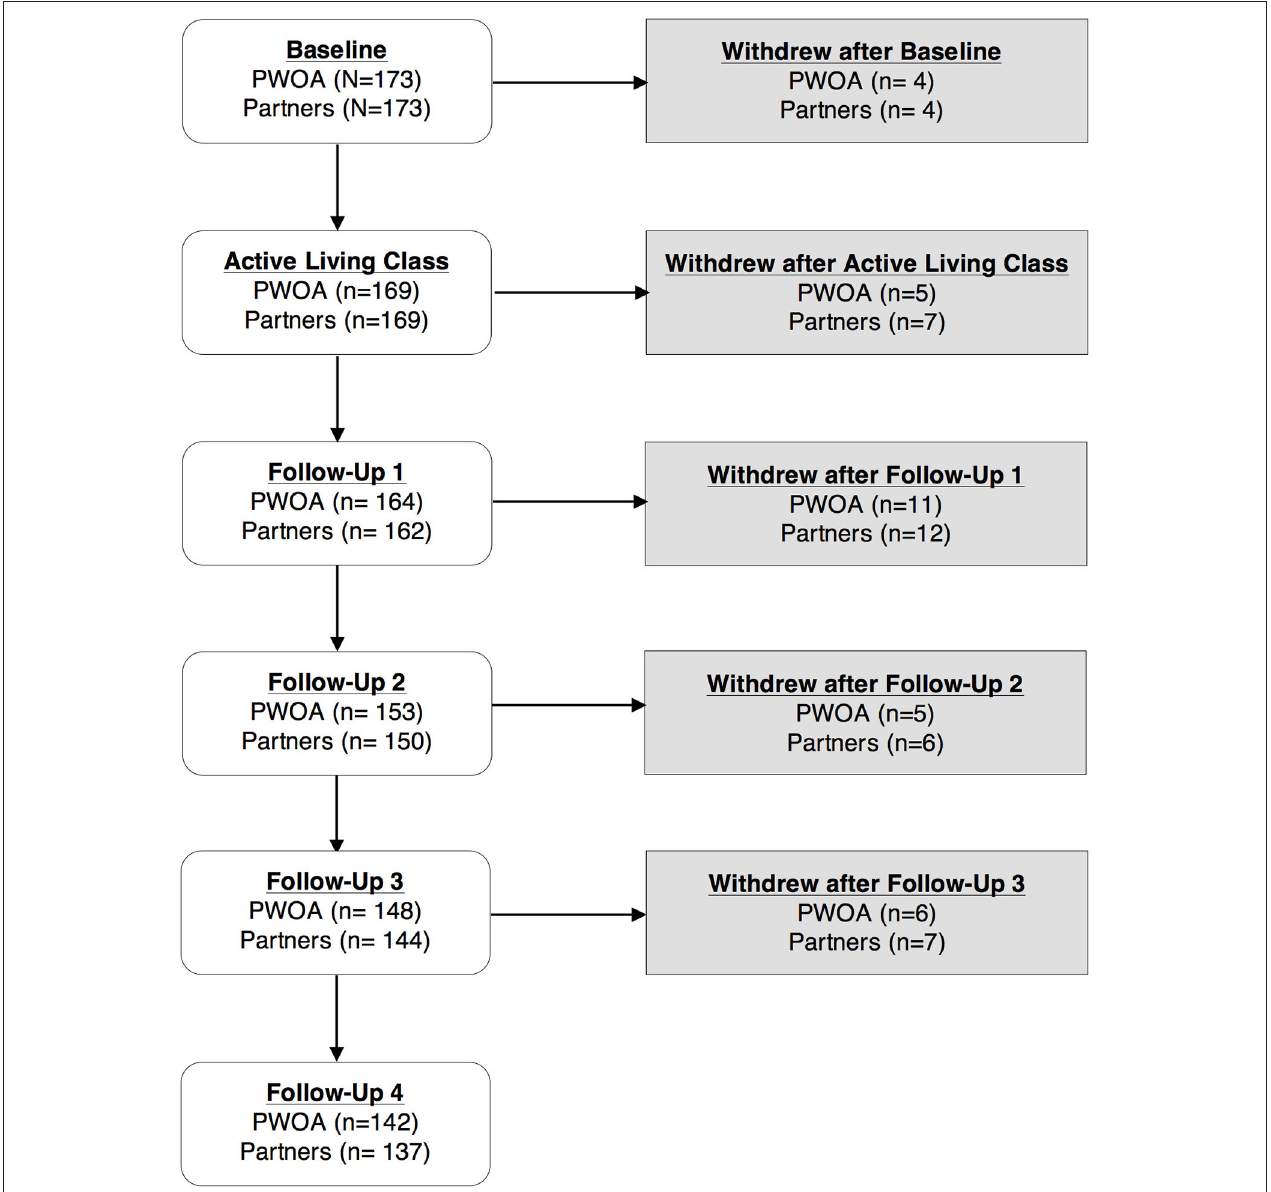
FIGURE 1 | Retention of PWOA and partners in the Partners in Active Living Study. PWOA, people with osteoarthritis; follow-up 1 = 1 week after ALC; follow-up 2 = 3 month after ALC; follow-up 3 = 6 month ALC; follow-up 4 = 12 month after